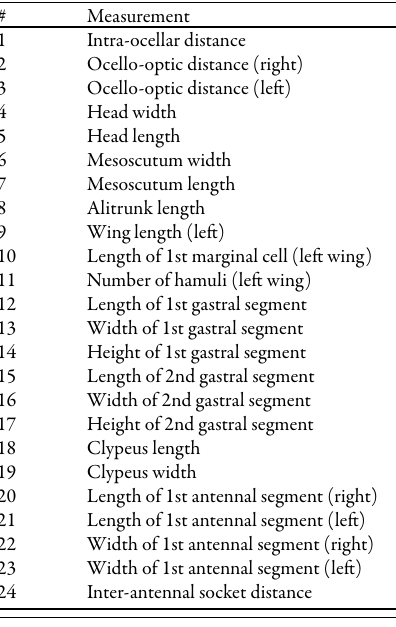
table 1: list of 24 measurements made from different body parts of Ropalidia marginata for calculating body size